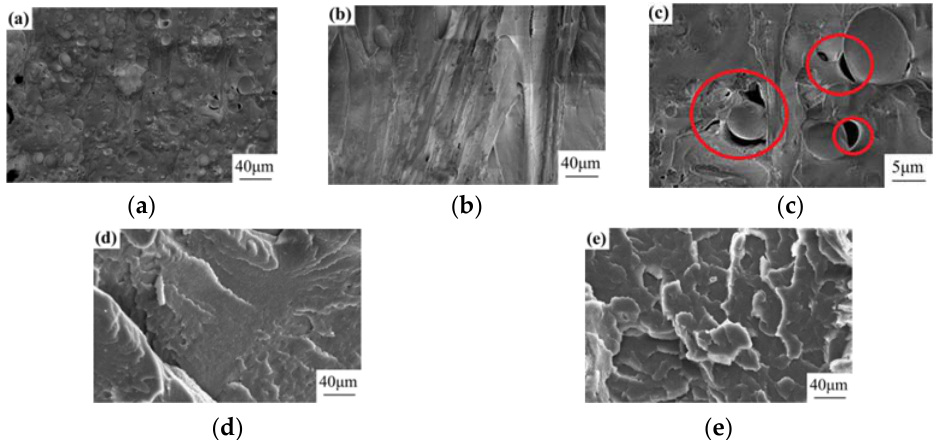
Figure 2. SEM photos of different compatibilizer contents. ( a ) is the morphology of the material amplified to 40 μ m at 1% compatibilizer, ( b ) is the morphology of the material amplified to 40 μ m at 3% compatibilizer, ( c ) is the cracks and holes in section when compatibilizer is 1%, ( d ) is the morphology of the material amplified to 40 μ m at 5% compatibilizer, ( e ) is the morphology of the material amplified to 40 μ m at 7% compatibilizer.